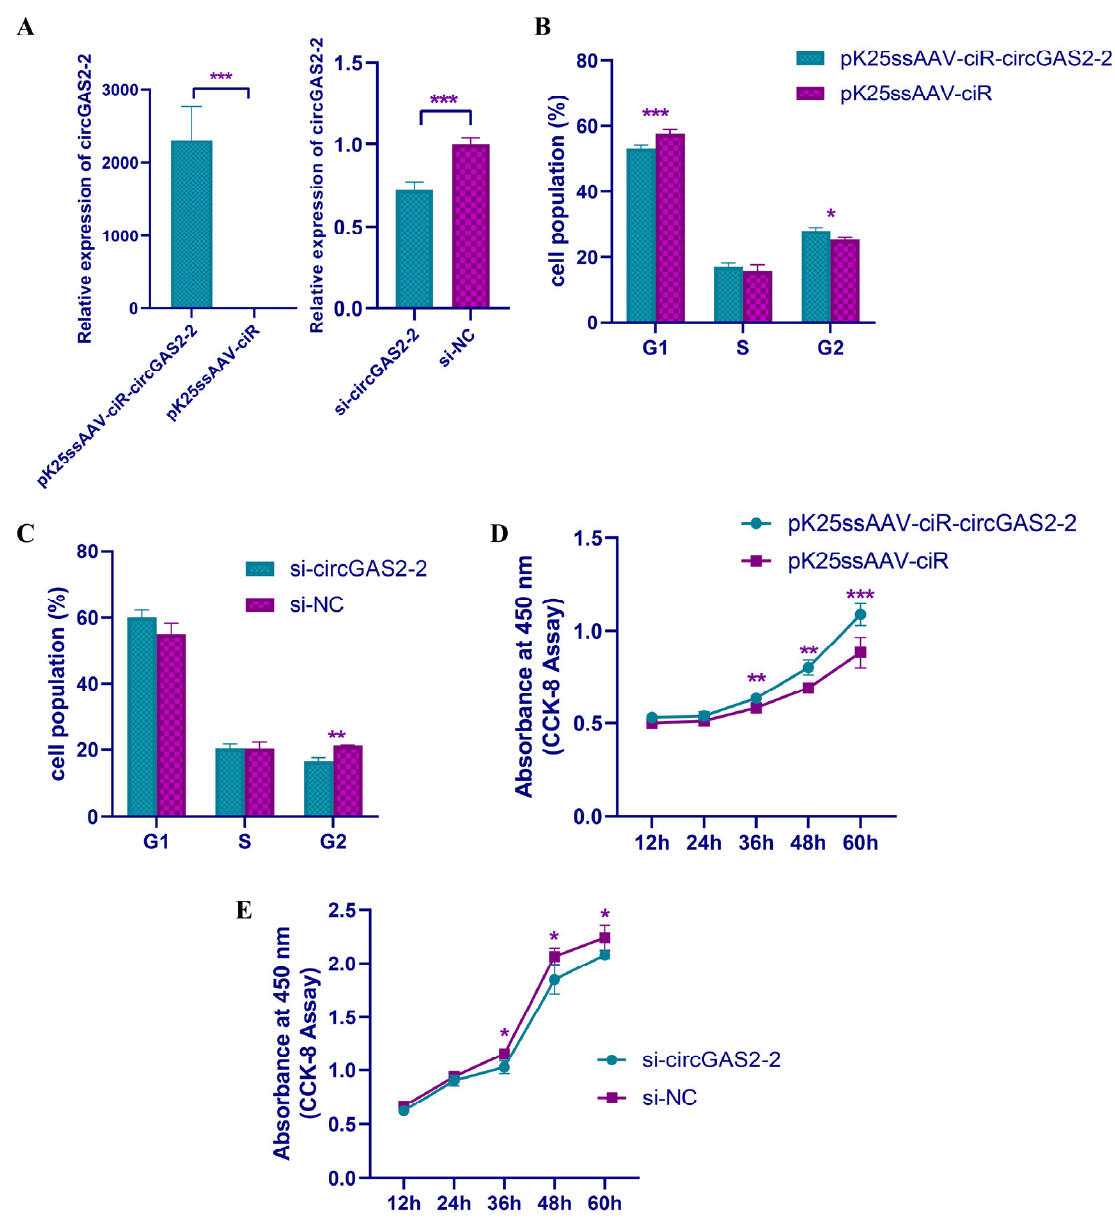
Figure 6. circGAS2-2 accelerates the cell cycle and promotes the proliferation of duck primary myoblasts. ( A ) Relative expression levels of circGAS2-2 after electroporation of myoblasts with pK25ssAAV-ciR-circGAS2-2/pK25ssAAV-ciR and si-circGAS2-2/siRNA NC for 48 h. ( B ) Analyses of the cell cycle after electroporation with pK25ssAAV-cirGAS2-2 or pK25ssAAV-cirGAS2-2 on duck primary myoblasts. ( C ) Analyses of the cell cycle after electroporation with si-circGAS2-2 or siRNA NC in duck primary myoblasts. ( D , E ) Cell-counting assay of duck primary myoblasts after electroporation with pK25ssAAV-ciR-circGAS2-2/pK25ssAAV-ciR and si-circGAS2-2/siRNA NC for 12 h, 24 h, 36 h, 48 h, and 60 h. The values are shown as means ± SEM. * p < 0.05; ** p < 0.01; *** p <